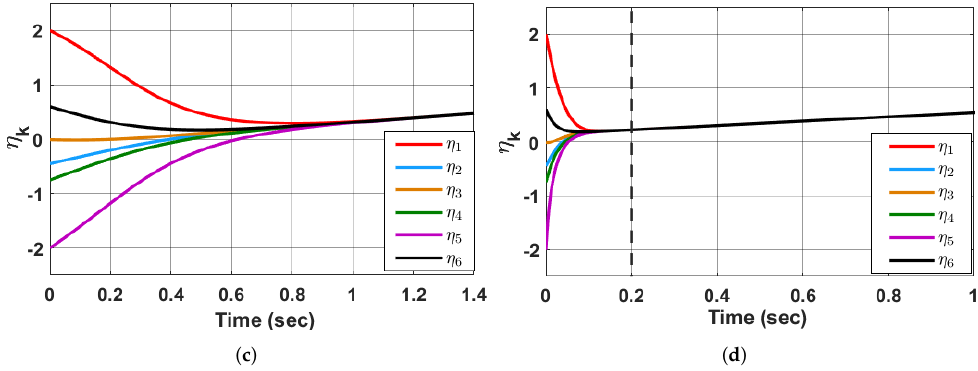
Figure 6. State evolutions of system (2) with time using the finite-time state-feedback controller designed in [51] with variations in the initial conditions (Finite-time synchronization) ( a , c ) and predefined-time state-feedback controller (32) with τ f = 0.2 s with variation in initial conditions ( b , d